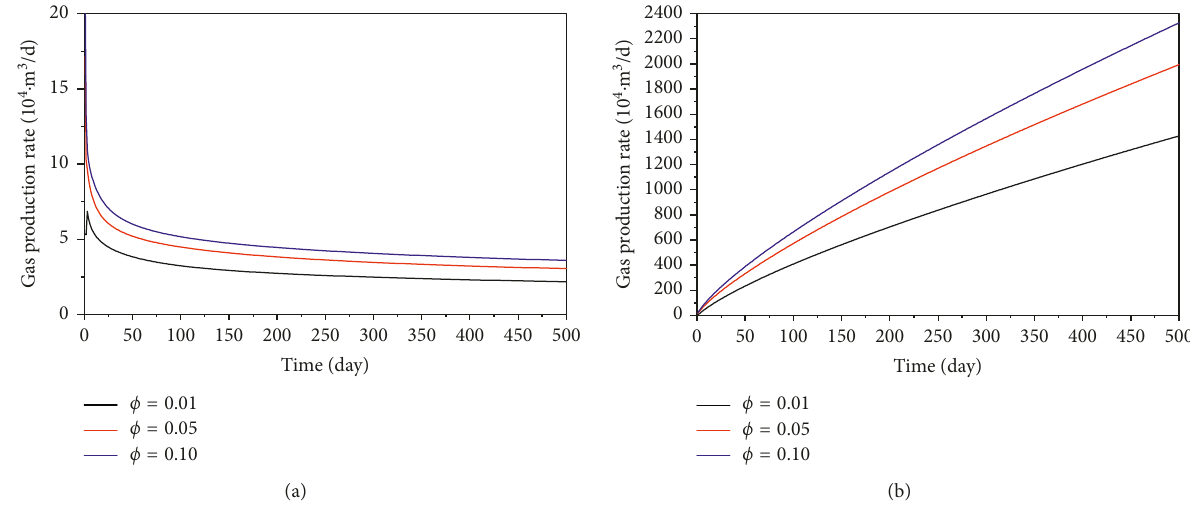
Figure 17: Effect of porosity on behavior of the multistage fractured horizontal well: (a) gas production rate; (b) cumulative gas production.